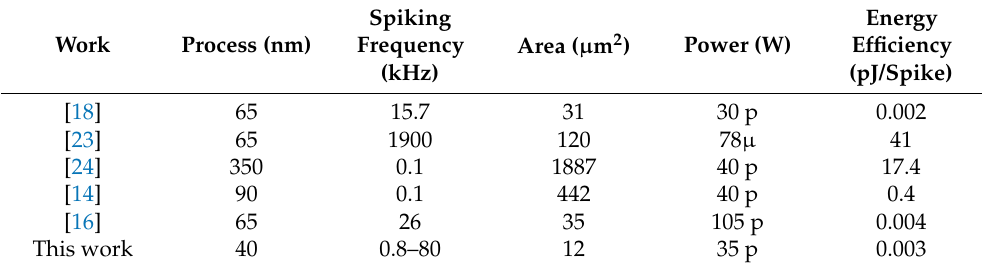
Table 1. Comparison of the design in this paper and the design in